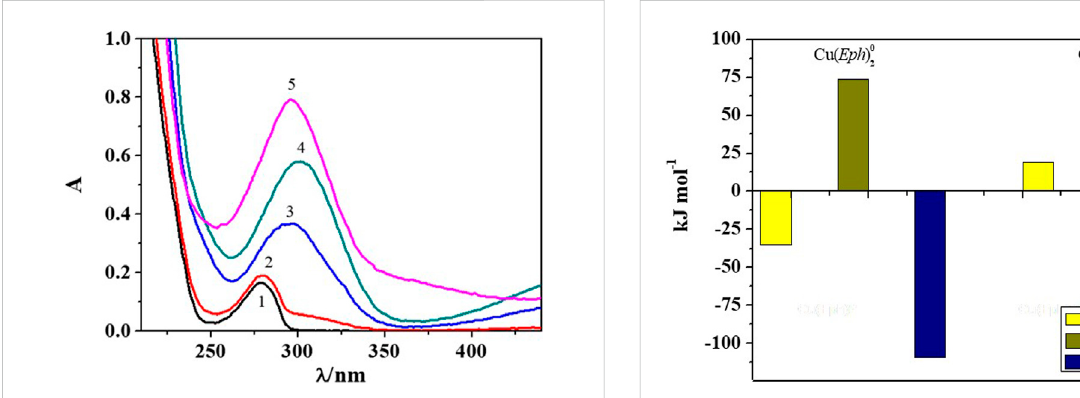
FIGURE 3 Bar plot for the enthalpy and entropy change values of the Cu 2+